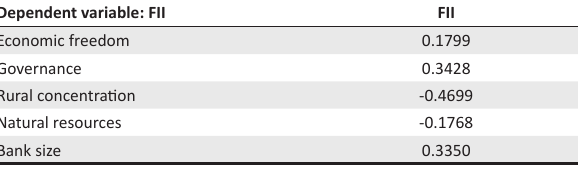
TABLE 7: Economic impacts of regression results.